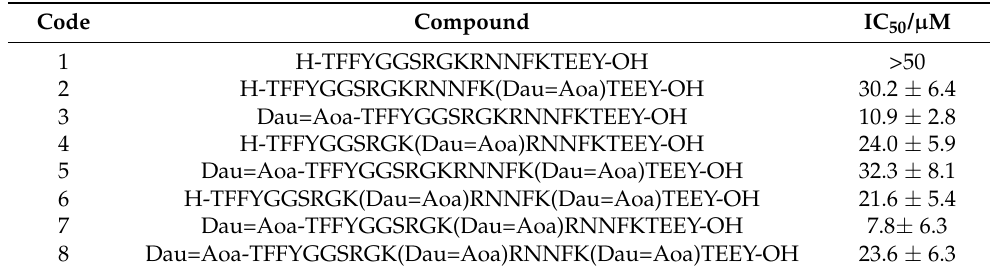
Table 1. The measured IC 50 values of the free Angiopep-2 peptide and the Angiopep-2–daunomycin conjugates. Code Compound IC 50 / µ M 1 H-TFFYGGSRGKRNNFKTEEY-OH